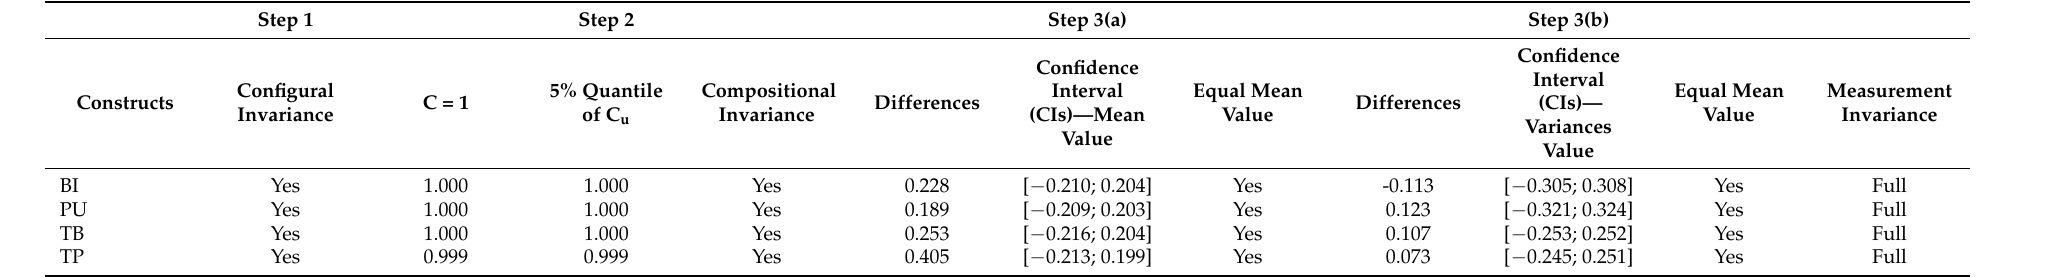
Table 9. Results of 3-step measurement invariance testing using